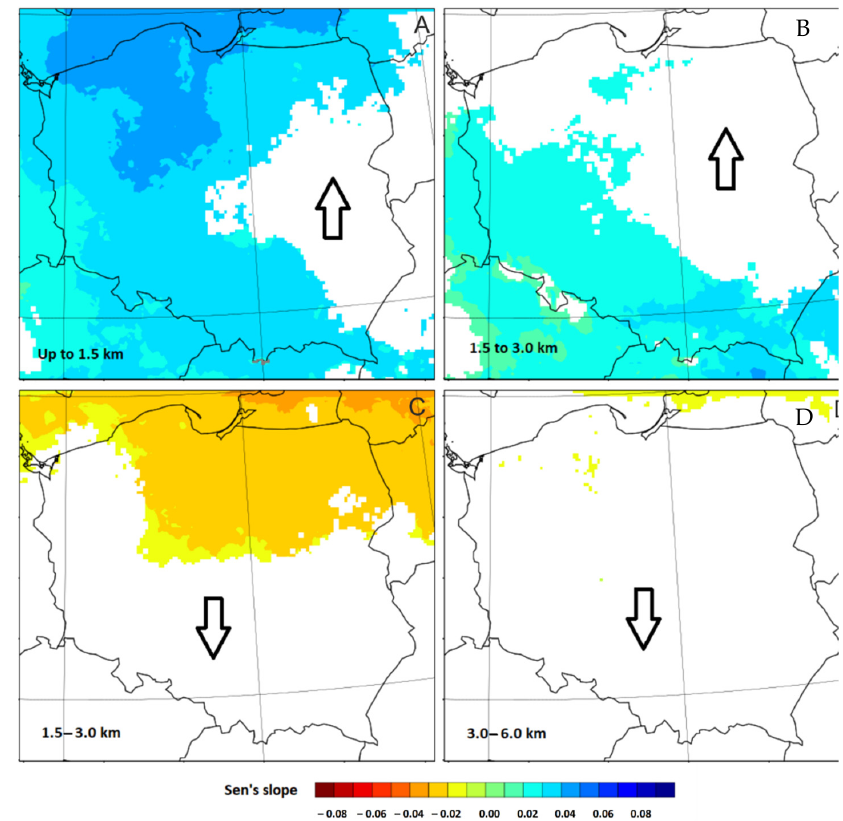
Figure 14. Sen’s slope for significant trends ( α = 0.05) of average summer PW at the level up to 1.5 km ( A ) and from 1.5 to 3.0 km ( B ) and average spring PW at the level from 1.5 to 3 km ( C ) and from 3 to 6 km ( D ) over Poland in the years 1983–2010. The arrows show the direction of PW changes over the area of Poland without statistically significant trends. Excluded grid points with altitude over 1.5 km above sea level are marked in